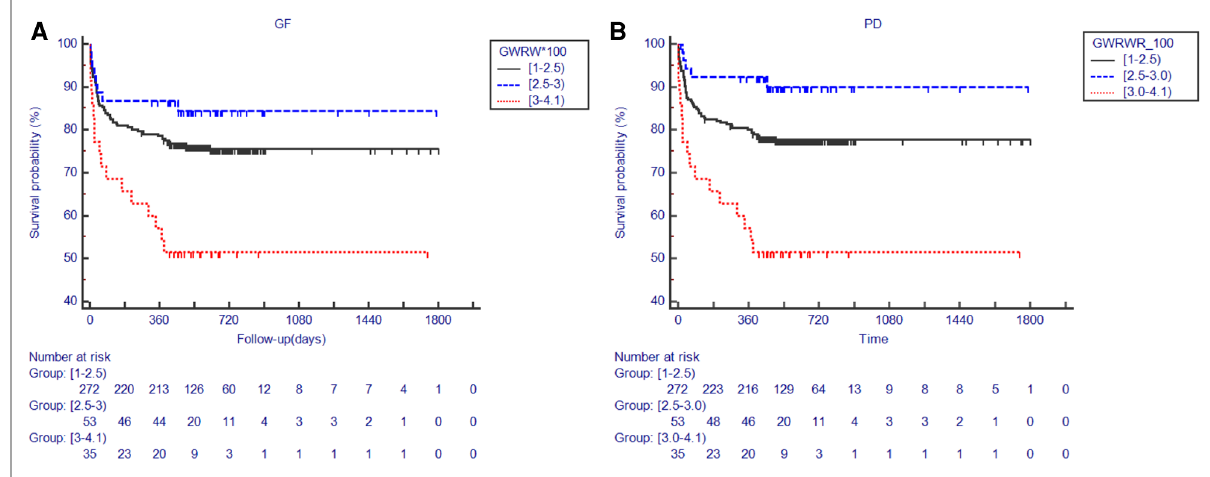
FIGURE 2 Kaplan – Meier plot for post-transplant outcomes in groups categorized by the GWRWR. ( A ) Comparisons on the GS rate categorized by the GWRWR; numbers at risk for each group with different GWRWRs in different periods presented under the Kaplan – Meier plot; ( B ) comparisons on the PS rate categorized by the GWRWR; numbers at risk for each group with different GWRWRs in different periods presented under the Kaplan – Meier plot. *represents signi fi cant differences compared with the group using grafts with a GWRWR between 1.0% and 2.5%. GS, graft survival; GWRWR, graft weight-to-recipient weight ratio; PS, patient